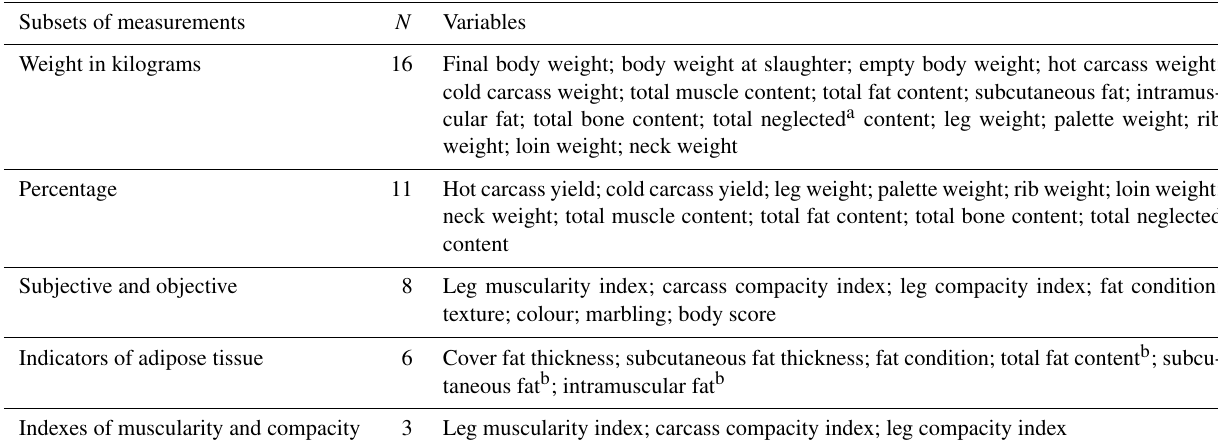
Table 2. Different subsets of variables established to develop multivariate analysis and evaluate the discrimination between carcasses of male Suffolk lambs fed with different concentrate supplementation and tropical grass